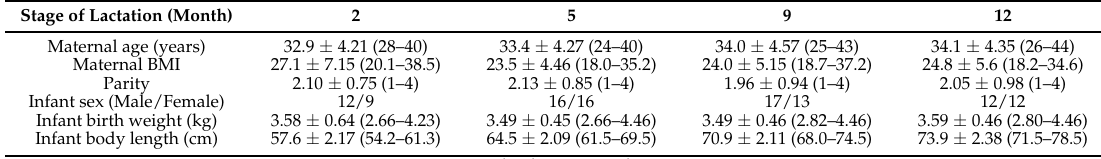
Table 1. Maternal and infant anthropometric and demographic characteristics ( n = 61). Values are mean ± SD (range). Table includes mothers who provided samples for multiple